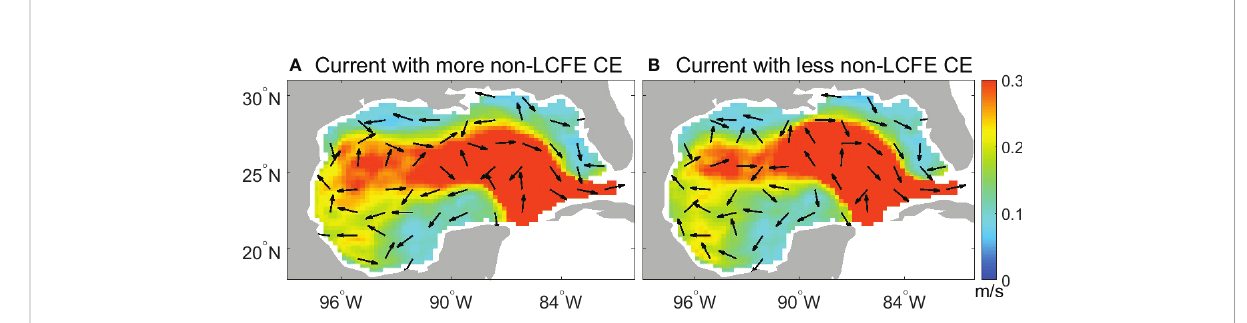
FIGURE 14 Composite of current speeds in the GoM (A) during the period with more generated non-LCFE CEs (annual number of non-LCFE CEs is larger than mean value plus one standard deviation), and (B) during the period with fewer non-LCFE CEs (annual number of non-LCFE CEs is smaller than mean value minus one standard deviation). Arrows denote the mean current